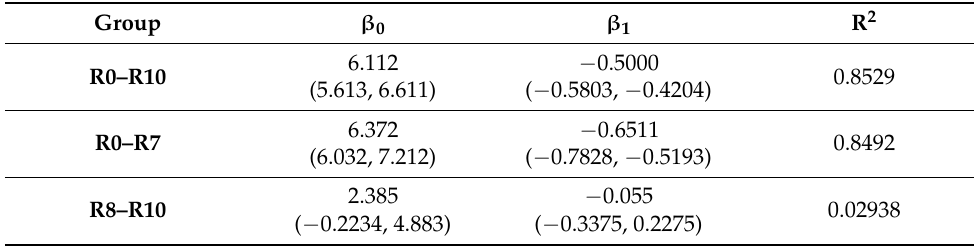
Table 6. Summary of results obtained from the linear fitting (R = β 0 + β 1 · RN) of the resilience. The coefficients β 0 and β 1 are accompanied with their 95% confidence bounds.